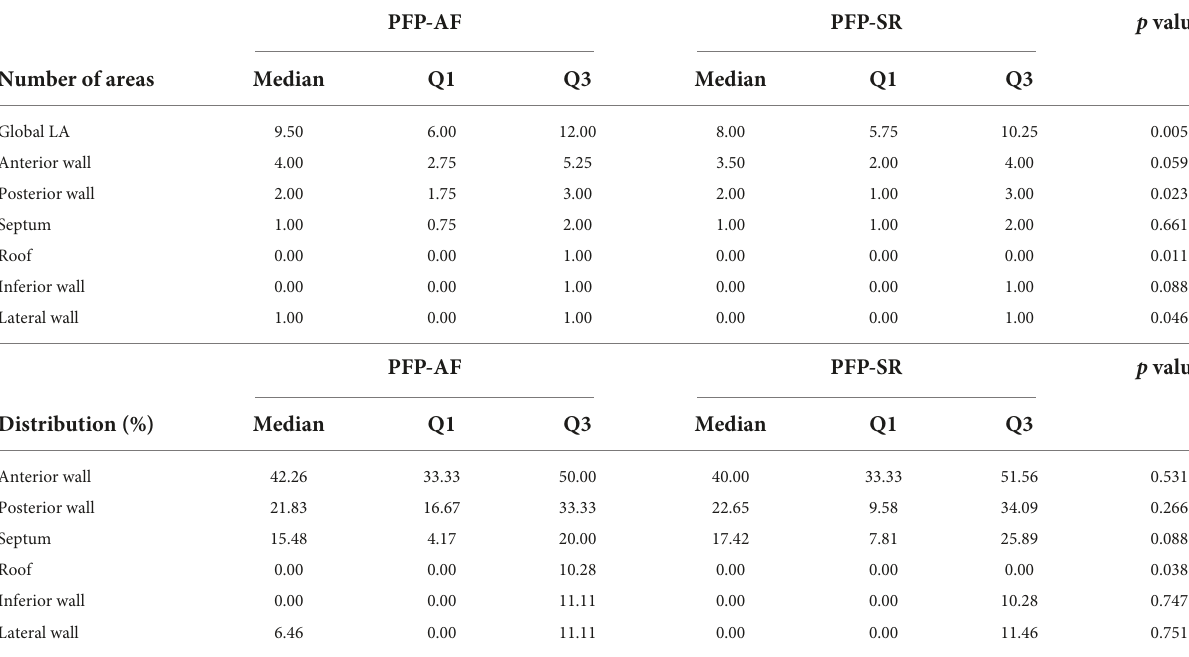
TABLE 2 Spatial distribution of prolonged fractionated potentials-atrial fibrillation (PFP-AF) and prolonged fractionated potentials-sinus rhythm (PFP-SR). PFP-AF PFP-SR p value Number of